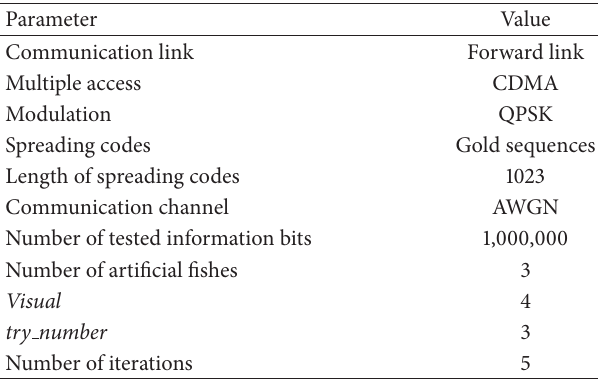
Table 1: Simulation parameters.